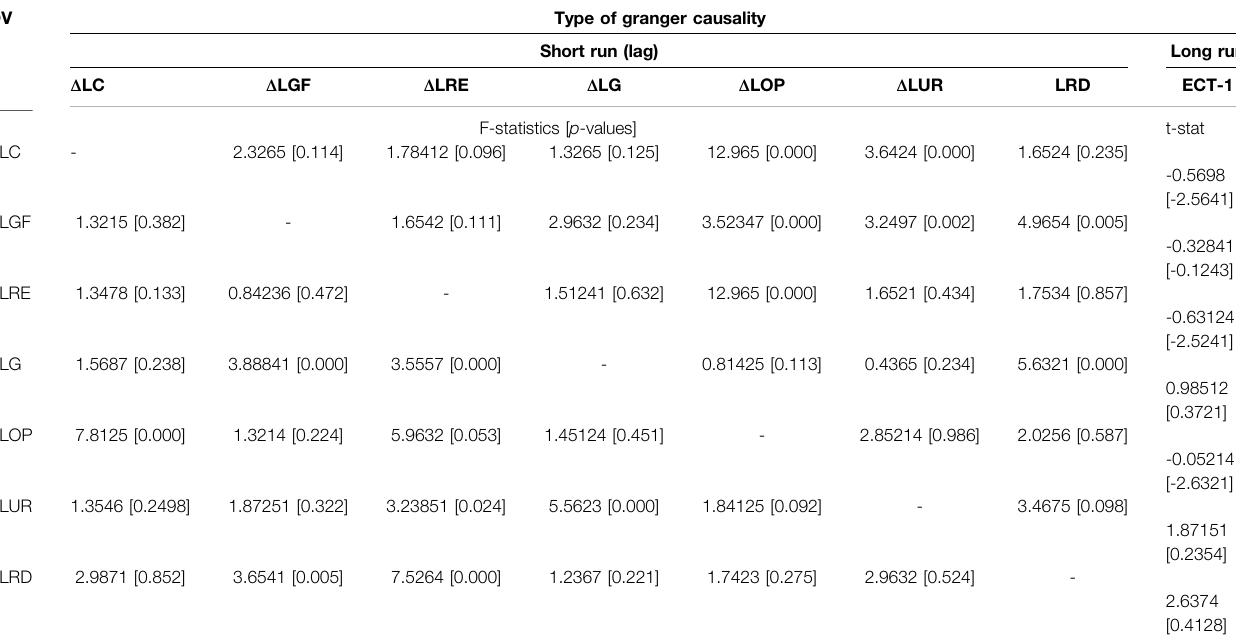
TABLE 8 | Outcomes of Granger causality